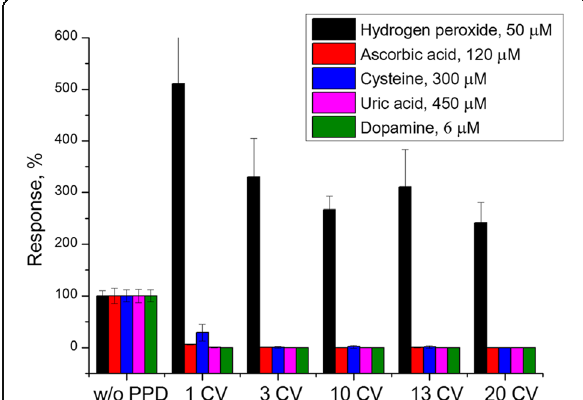
Fig. 3 Efficiency of PPD membranes deposited using different number of CVAs